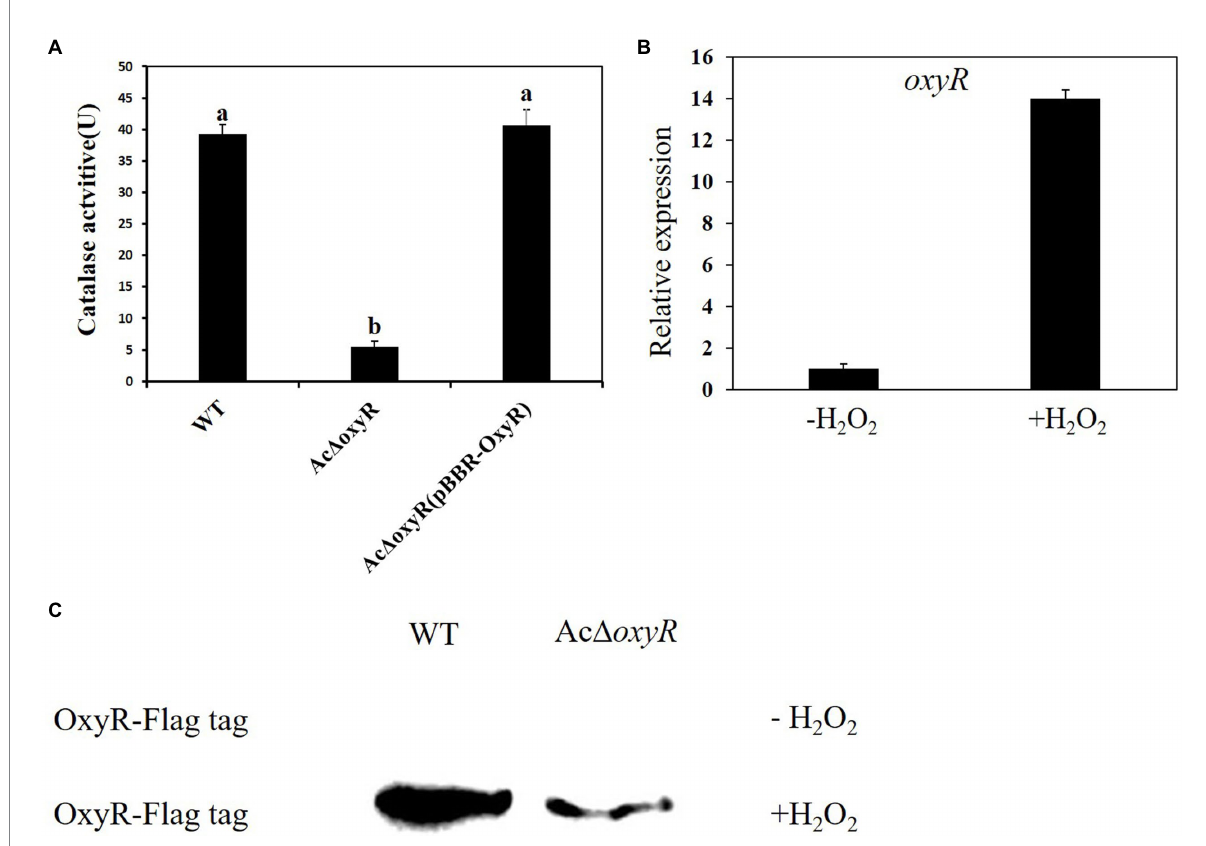
FIGURE 1 Assays for catalase activity and expression of oxyR of A. citrulli strains in response to H 2 O 2 . (A) Catalase activity assays. Catalase activities associated with cell extracts were assessed by spectrophotometric assay. One unit of catalase activity was defined as the amount of activity required to decompose 1 μ mol of H 2 O 2 per minute under the assay conditions. Different lowercase letters indicate a significant difference between treatments. Statistically significant differences were determined by the one-way ANOVA of variance and p < 0.05. (B) Expression of the oxyR in A. citrulli WT grown in LB medium with or without 1 mm H 2 O 2 and determined by qRT-PCR. Error bars indicate standard deviations. Statistically significant differences were determined by the one-way ANOVA of variance and p < 0.05. (C) Abundance of OxyR-Flag in the WT and Ac Δ oxyR grown in LB medium with or without 1 mm H 2 O 2 and determined by western blot analysis. Experiments were repeated three times with similar